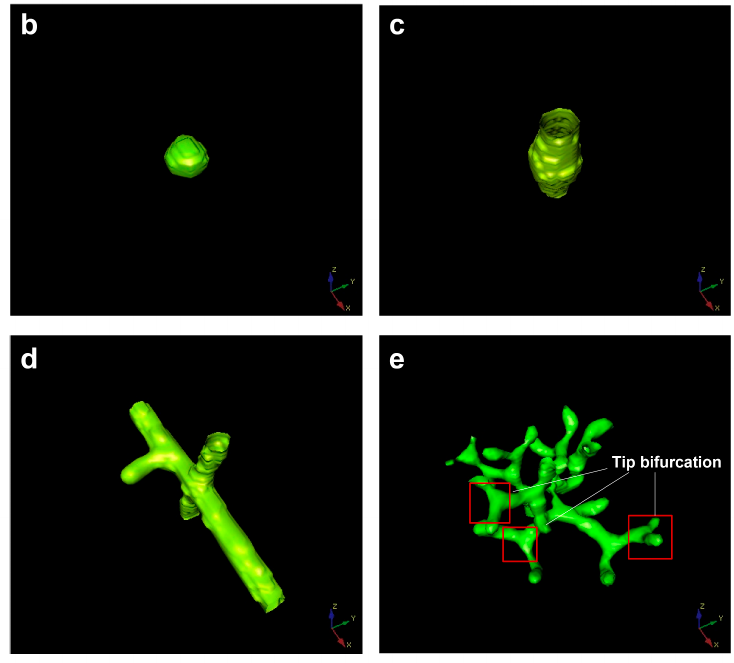
Figure 7. ( a ) The distribution laws of the types of branching behaviors within the μ - v parameter domain according to the simulation results. The μ - v parameter domain is composed of five different branch patterns, which are: Y = 1 everywhere pattern (spatial spillover type, area A), no branching events (no branch type, area B) pattern, only branches (only parent branch type, Y represents the Y variable in the equation, area C) pattern, side branches (side branches type, area D) pattern, and tip bifurcation (tip splitting type, area E) pattern. The multicellular morphologies corresponding to areas B–E are shown in graphs ( b – e ) respectively.